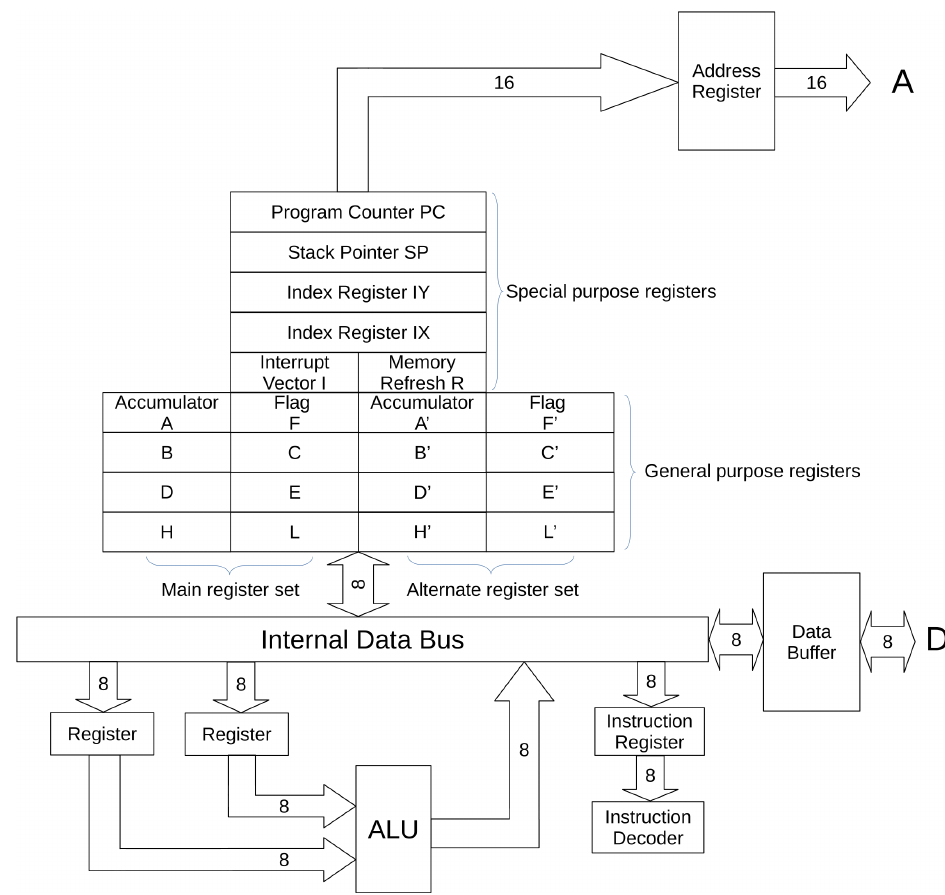
Figure 3. T80 internal structure, based on figures by Thomas Scherrer, adapted with permission from [45]. Copyright 1995, Zilog